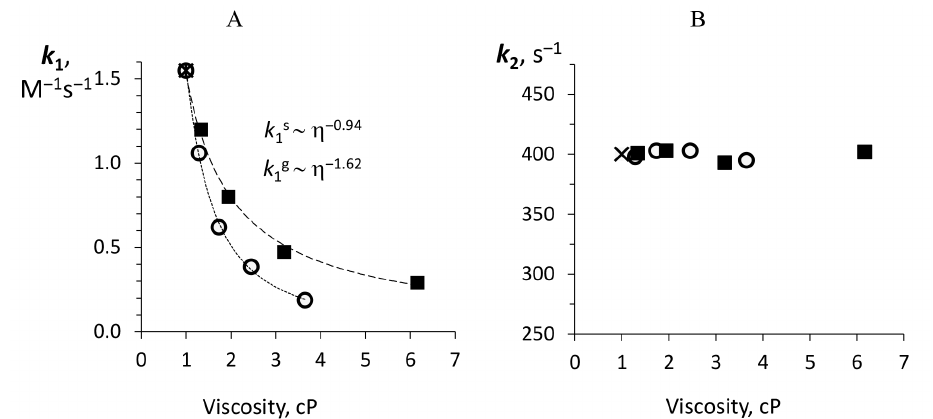
Figure 5. The dependence of the rate constants for the reduced flavin binding, k 1 ( A ) and C(4a)- hydroperoxyflavin formation, k 2 ( B ) on viscosity for glycerol (the empty markers) and sucrose (the filled markers) solutions. The dashed lines refer to the power law approximation with the indicated exponents. The cross shows the value in the buffer solution. Superscripts g and s refer to glycerol and sucrose correspondingly.